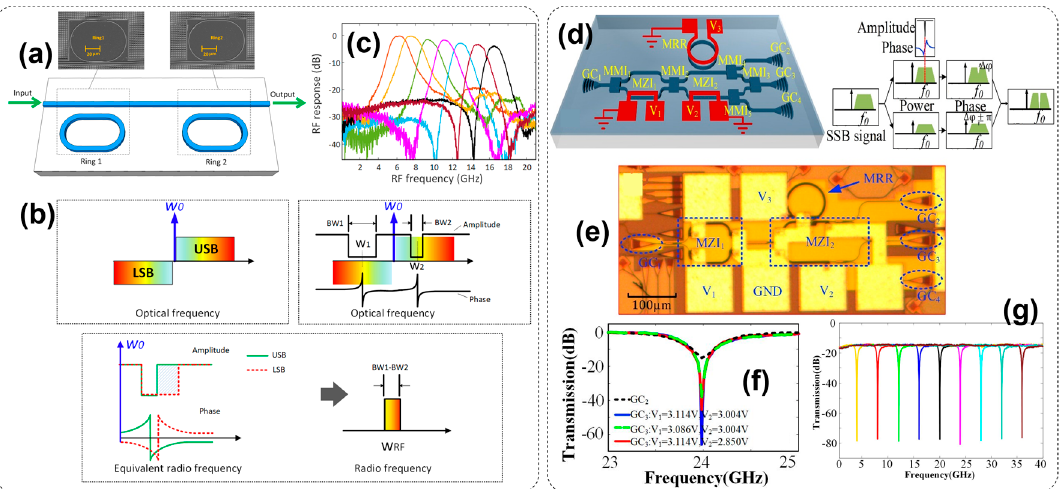
Figure 20. ( a )–( b ) Bandpass MPF based optical double notch filter reported in [114]: ( a ) Schematic diagram of the optical double notch filter, ( b ) operation principle of the proposed MPF, and ( c ) measured RF responses. Courtesy of and adapted from Xiaoke Yi [114]. ( d )–( g ) Ultrahigh peak rejection notch MPF proposed in [115]: ( d ) The structure and concept of the proposed MPF, ( e ) optical micrograph of the fabricated device, and ( f )–( g ) experimental results. Courtesy of and adapted from Yuan Yu [115].